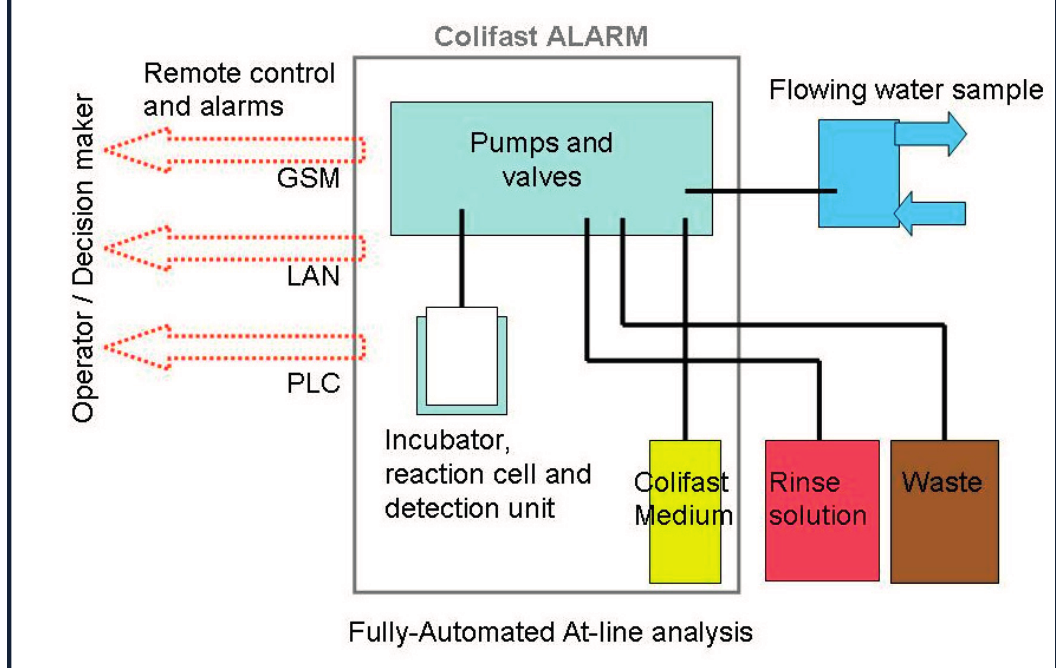
Figure 1. Technical overview of the Colifast ALARM™ including interface options for remote control: Global System for Mobile Communications (GSM), Local Area Network (LAN) and Programmable Logic Controller